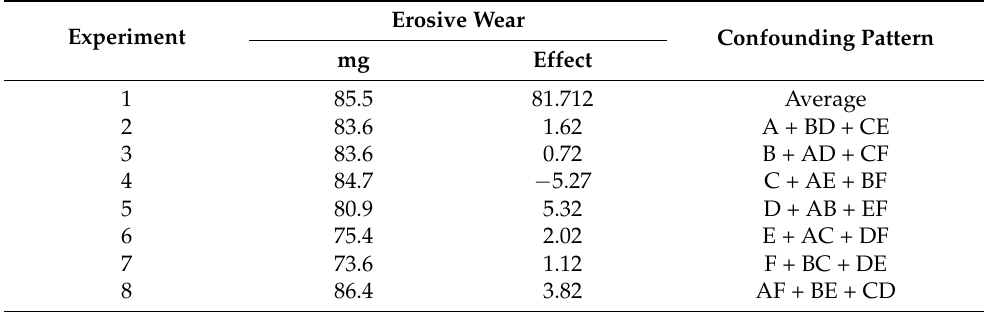
Table 6. Weight loss in the erosive wear (mg) test. The effects refer to the confounding pattern highlighted in the right-hand column. The average values refer to the average value of the 8 experiments.